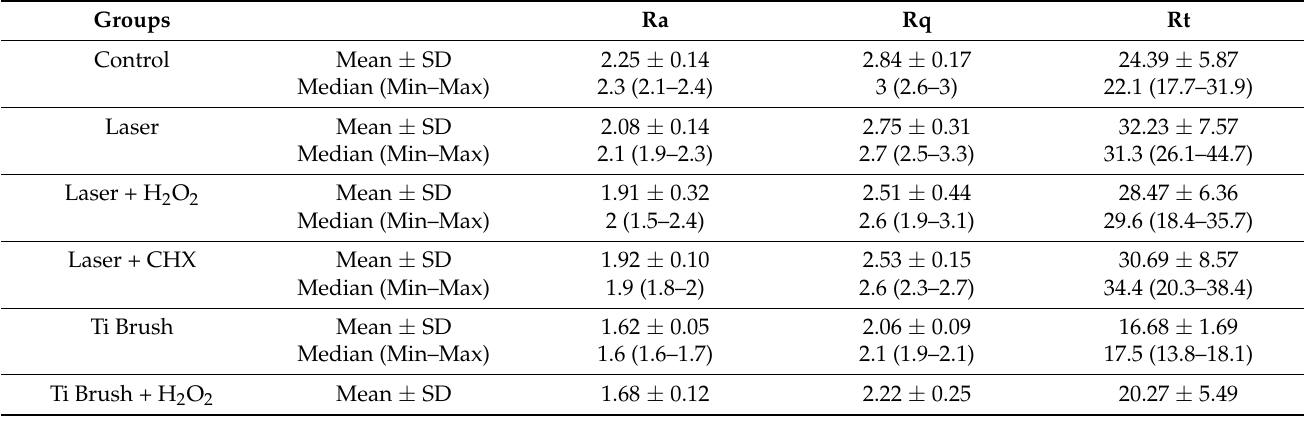
Table 2. Variation and initial statistical analysis of surface roughness values of Ti post